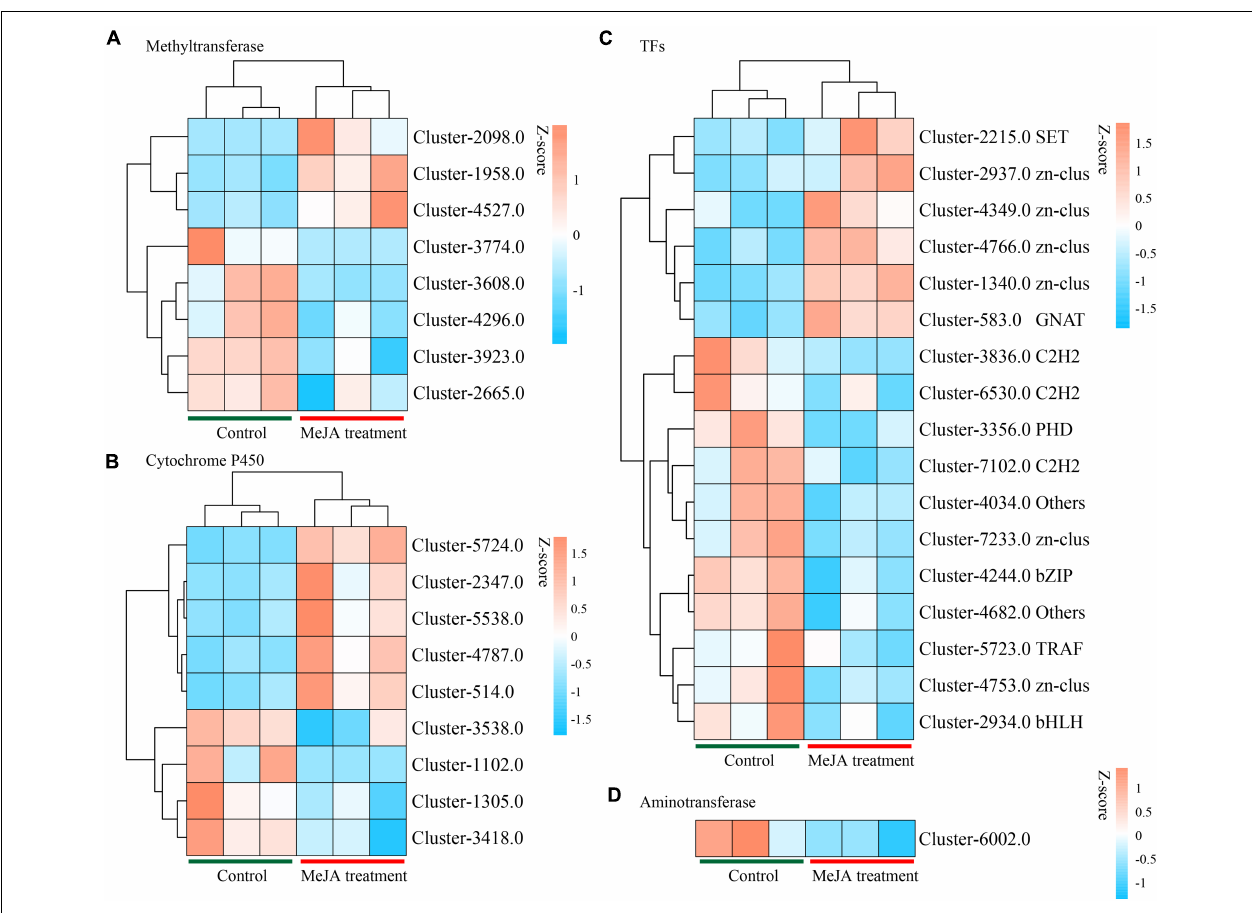
FIGURE 6 | Heat map analysis of genes in backbone post-modification. (A) Heat map analysis of methyltransferases. (B) Heat map analysis of Cytochrome P450 family. (C) Heat map analysis of TFs. (D) Heat map analysis of